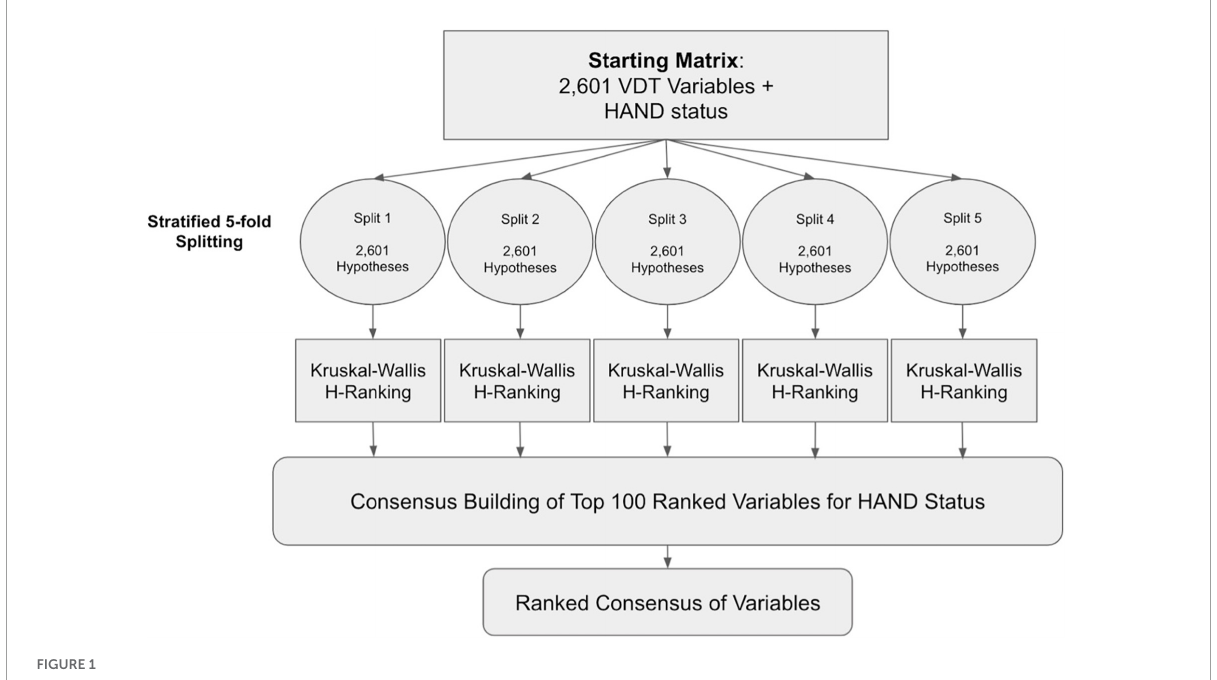
FIGURE1 Analytical workflow for dimensionality reduction via a two-stage variable